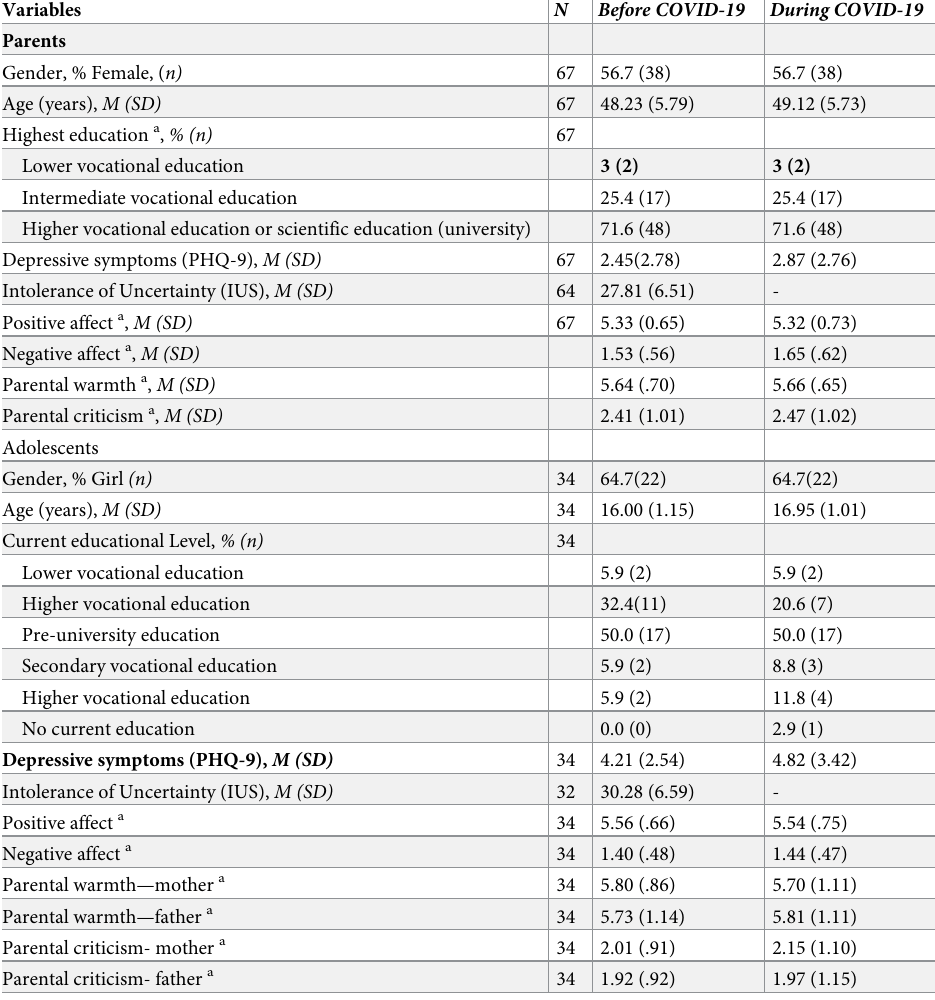
Table 1. Sample characteristics and study